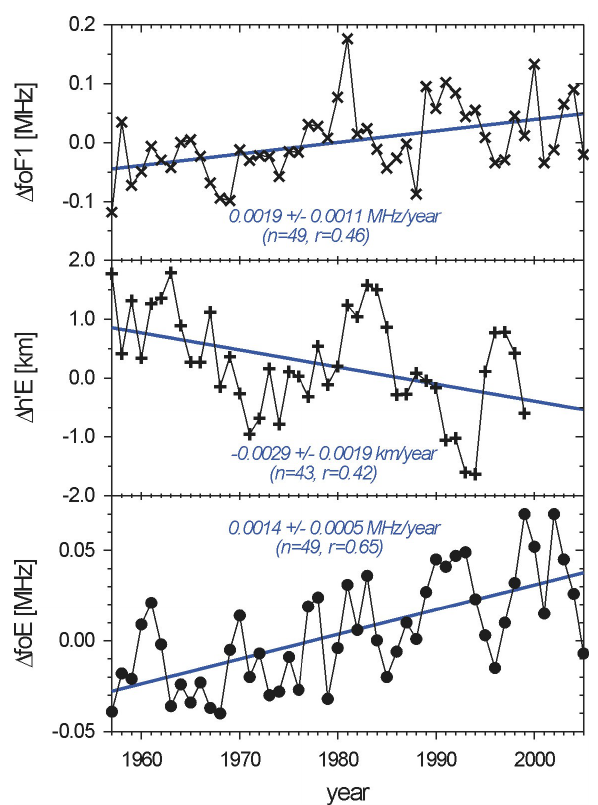
Fig. 3. Mean global trends of fo E, h 0 E , and fo F1 using data of globally distributed ionosonde stations (updated initial data series of 72 stations for fo E, 33 for h 0 E , and 51 for fo